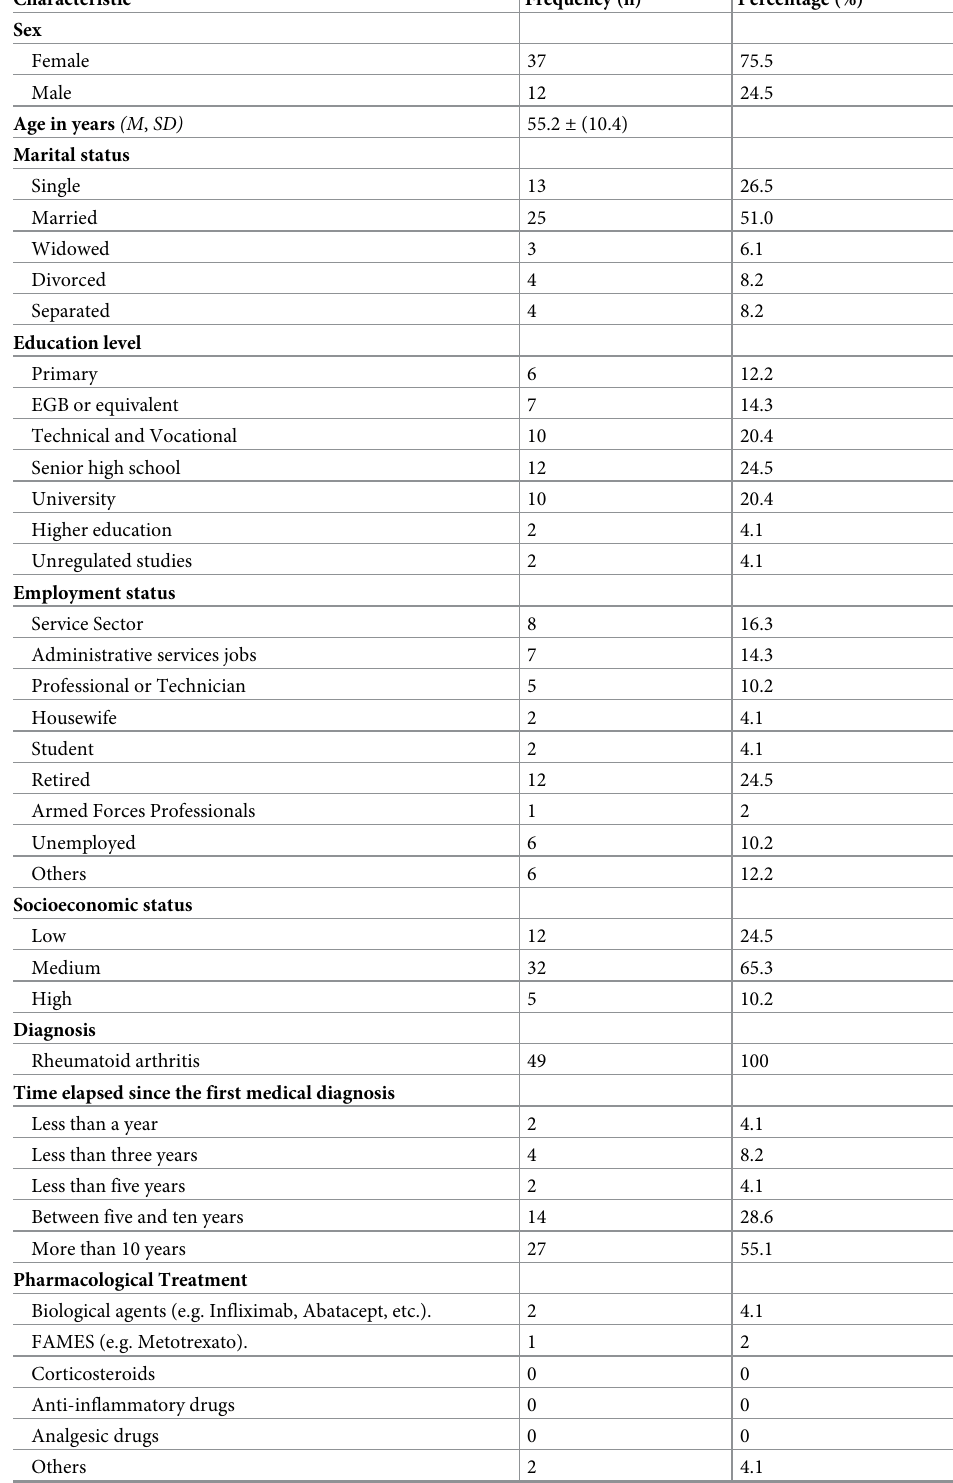
Table 1. Sociodemographic characteristics and clinical variables of the study